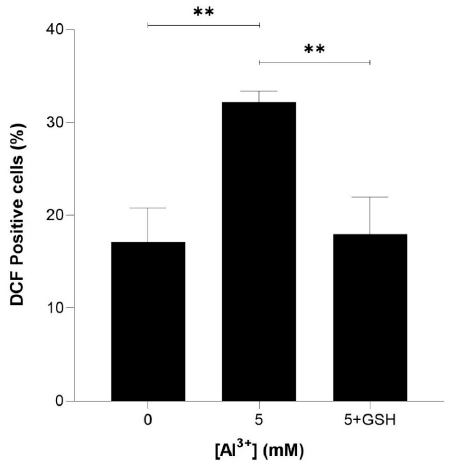
Figure 6. Glutathione (GSH) rescue of Al 3+ -induced ROS generation in S. cerevisiae BY4743 [pYEX.A β ] using 2,7-dichlorodihydrofluorescein diacetate (H 2 DCFDA) staining. Bars represent dichlorofluorescein (DCF)-positive cell counts after 5 mM Al 3+ treatment, 5 mM GSH was used to rescue cells from oxidative stress caused by treatment with 5 mM Al 3+ and the presence of A β 42 . Values are from triplicates; the mean and standard deviation are shown. Values significantly dif- ferent from 0 mM, 5 mM Al 3+ and GSH rescue in a one-way ANOVA with Tukey’s post hoc analy- sis are indicated with asterisks: ** p < 0.0040. Al 3+ cytotoxicity was tested for its ability to reduce cell viability and cause growth inhibition in yeast expressing GFP and GFP fused to A β 42 . The cytotoxicity, reduction in cell viability, and growth inhibition caused by Al 3+ and enhanced by A β 42 was found to be due to increased production of ROS leading to enhanced oxidative stress, a characteristic hallmark of AD. Results of the toxic effects of Al 3+ and A β 42 seen are independently supported by sev- eral reports. Al 3+ is a known pro-oxidant and has been shown to exacerbate oxidative events [1,24–26] resulting in apoptosis, which is thought to be the general mechanism of Al 3+ toxicity towards cells [27]. Mammalian studies of cortical and hippocampal neurons treated with A β 42 indicated that A β 42 induced the degeneration and death of cells via apoptosis [28]. These results have been further supported in studies demonstrating that treating mammalian cells with Al 3+ enhances cell death in a time- and dose-dependent manner, exhibiting characteristic features of apoptosis such as shrinkage of cell bodies and hypercondensed, irregularly shaped chromatin [29]. Al 3+ has also been shown to in- duce the degeneration of human astrocytes via apoptosis resulting in neuronal death [30]. Further, the toxic synergy of A β 42 and Al 3+ observed in the current study is supported by studies that demonstrated A β 42 conjugated with Al 3+ significantly disrupted Ca 2+ homeo- stasis and affected mitochondrial respiration to a greater extent than A β 42 alone or when it was conjugated with other metal ions [31,32]. A recent study assessed Al 3+ toxicity towards human neuroblastoma, SH-SY5Y cells, and showed a time- and concentration-dependent effect. Concentrations of 500 and 300 μ m severely inhibited growth proliferation when exposed to Al 3+ for 48 and 72 h,